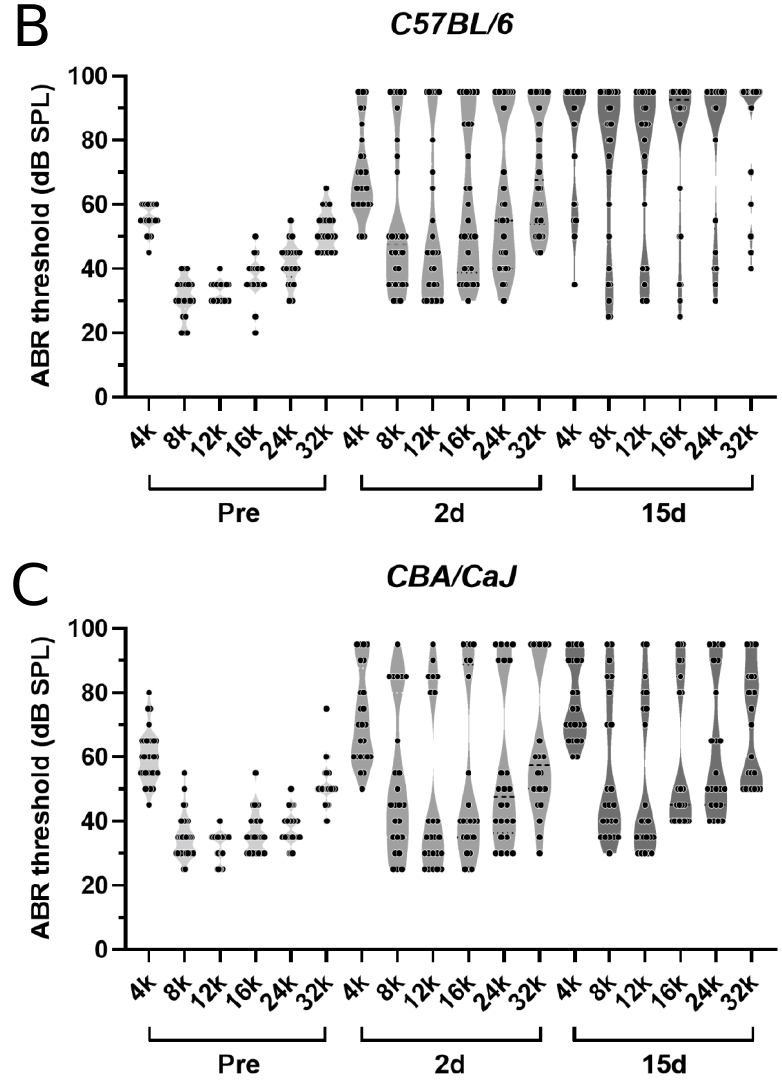
Figure 1. ABR thresholds elevated differentially in B6 and CBA mice after 400 G/200 F treatment. ( A ) Average ABR thresholds before, 2 days after, and 15 days after the treatment, in B6 (circles) and CBA (squares) mice. 5-pointed asterisks depict the statistical significance of ABR threshold comparisons between 15-d B6 and 2-d B6 mice, while 6-pointed asterisks depict the comparisons between 15-d B6 and 15-d CBA mice. * p < 0.05, ** p < 0.01, post hoc Šídák's multiple comparisons tests. Error bar = SEM. ( B ) Violin plots of ABR thresholds from individual B6 mice. ( C ) Violin plots of ABR thresholds from individual CBA mice.